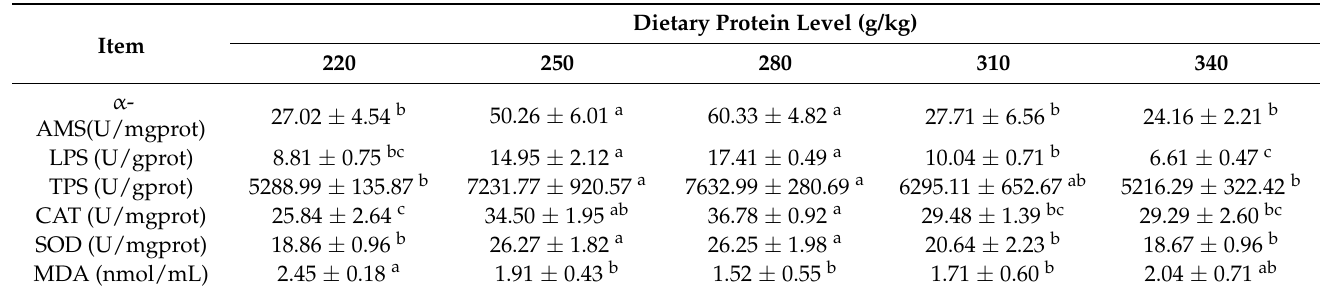
Table 3. Effects of different dietary protein levels on the intestinal enzyme activities of Cyprinus carpio haematopterus